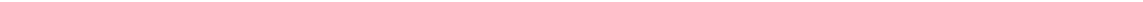
Fig. 5d) of Bmal1 Myeloid − / − mice with EAE compared with